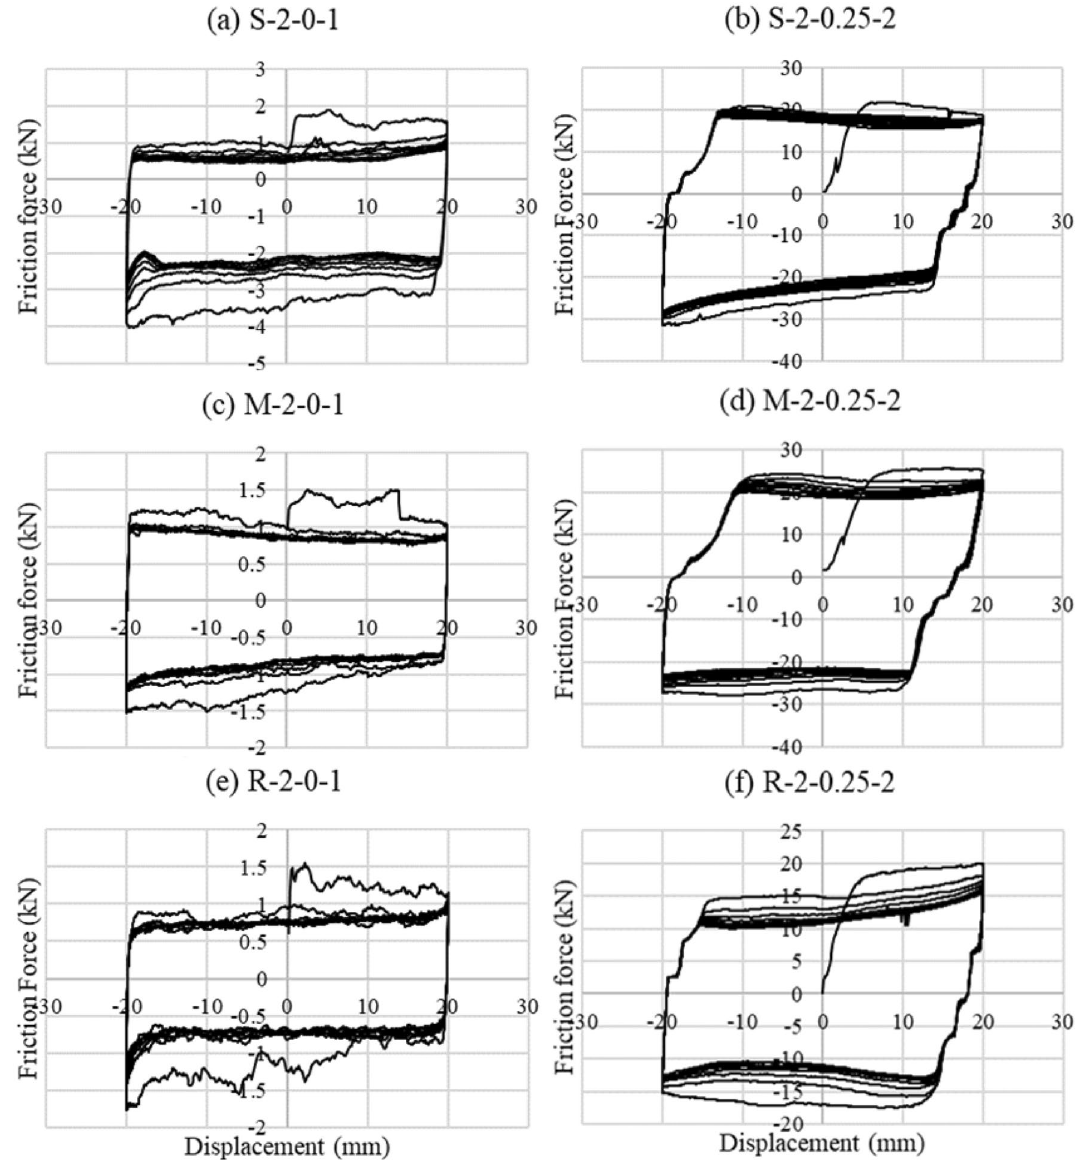
Figure 10. Friction force versus displacement graphs for tests with different vertical